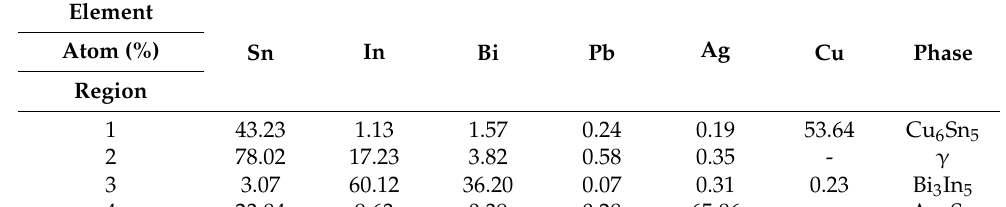
Figure 8. XRD analysis results of the mixed solder joint formed by SAC305 and 13.5Sn-37.5Bi-45In- 4Pb after reflowing at 140 °C for 5 minutes.